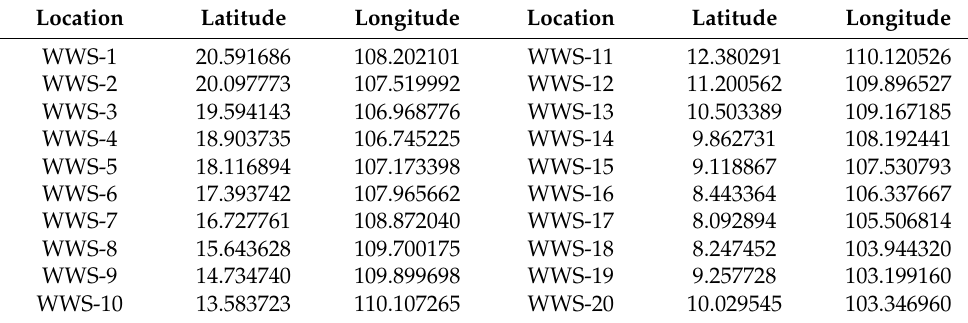
Table A1. The proposed locations’ coordinates.